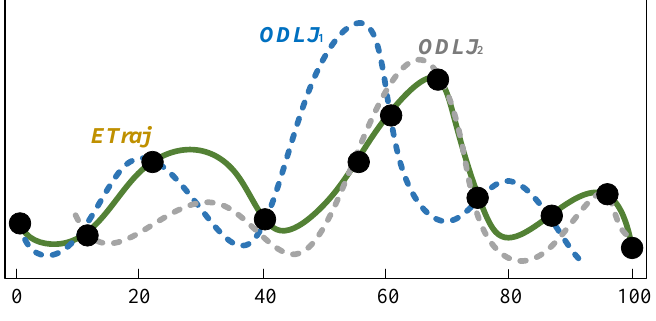
Figure 4. The segmentation of the matching feature window. Algorithm 1 for realizing matching feature points 𝑃 and establishing search window 𝑊 of abnormal trajectory range is as follows. Algorithm 1. Algorithm for establishing anomalous trajectory range retrieval window